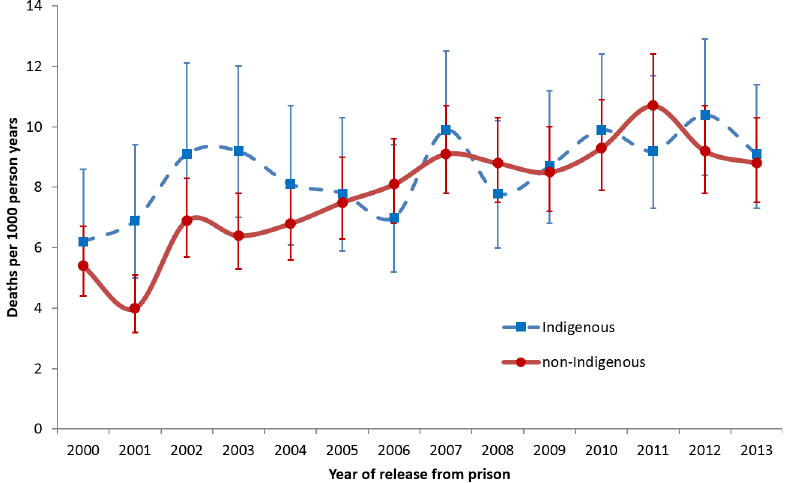
Fig 3. Estimated CMR within 365 days of release nationally, 2000 – 2013, based on Centrelink data, by Indigenous status.